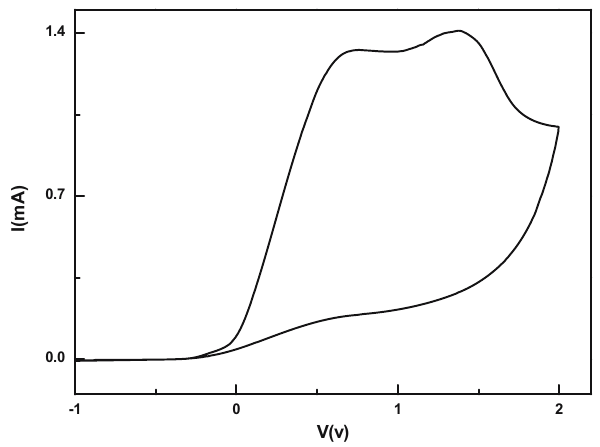
Figure 1: VC of anodic electropolymerization of thiophene on oxided PSi surface with a sweep rate of 20 mV · s − 1